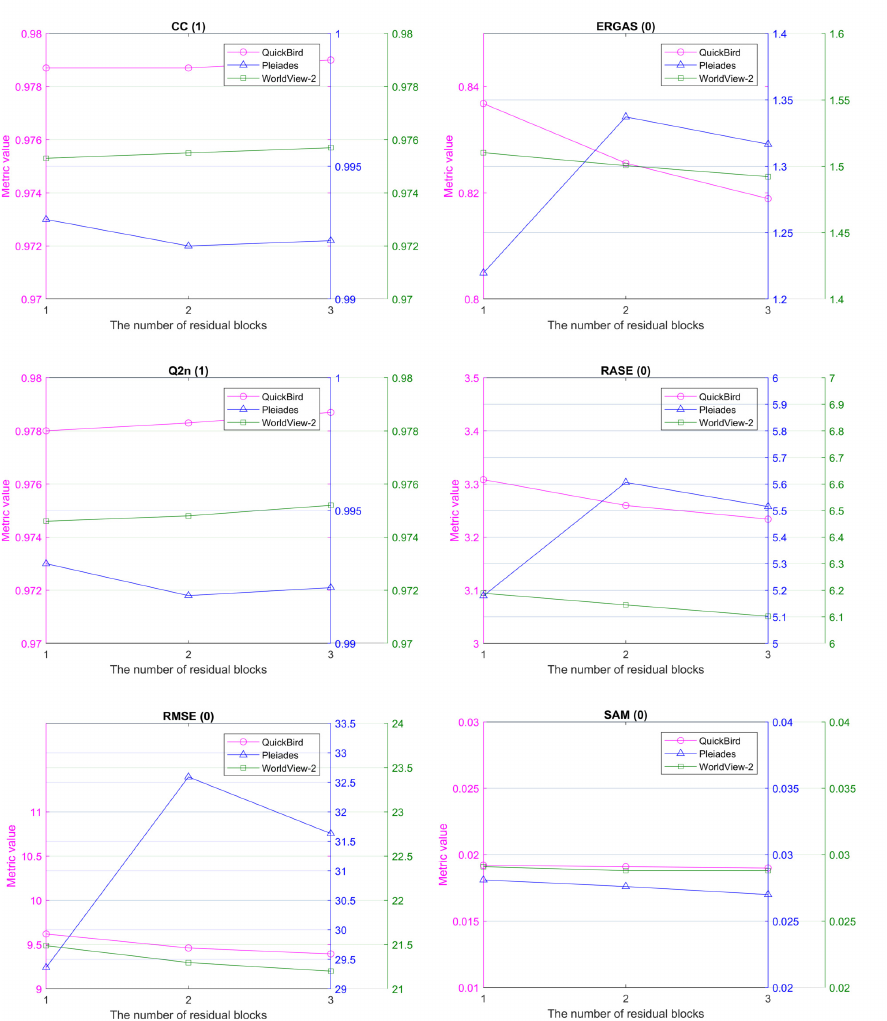
Figure 13. Quantitative fusion results by varying the number of residual blocks on the three real remote sensing